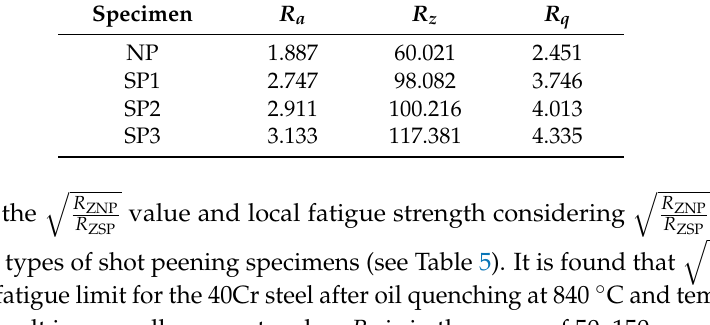
Table 5. Predictive value vs. experimental